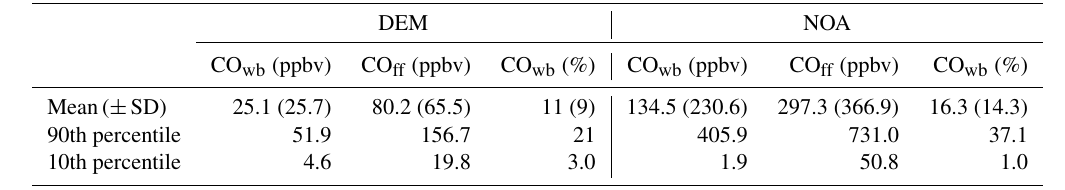
Table 3. Statistical summary of calculated CO wb and CO ff concentrations, as well as CO wb (%), using the multiple regression model (model 1) at DEM and NOA stations.